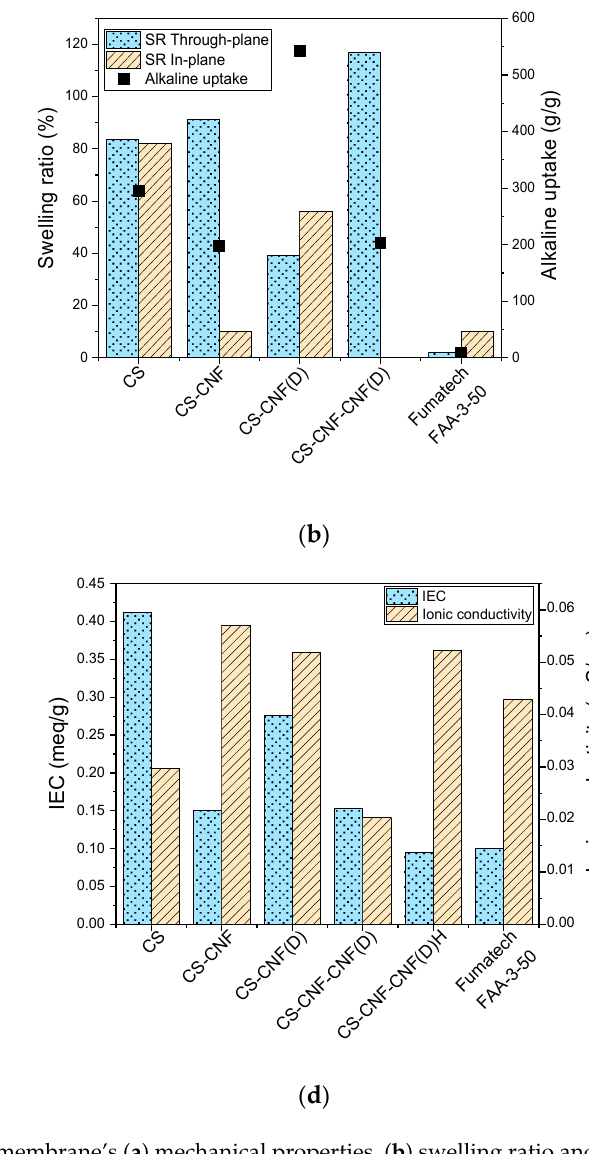
Figure 10. Comparison of the membrane’s ( a ) mechanical properties, ( b ) swelling ratio and alkaline uptake, ( c ) ethanol (EtOH) permeability, ( d ) ion exchange capacity and ionic conductivity for the CS-based AEMs and the commercial Fumatech FAA-3-50 AEM.